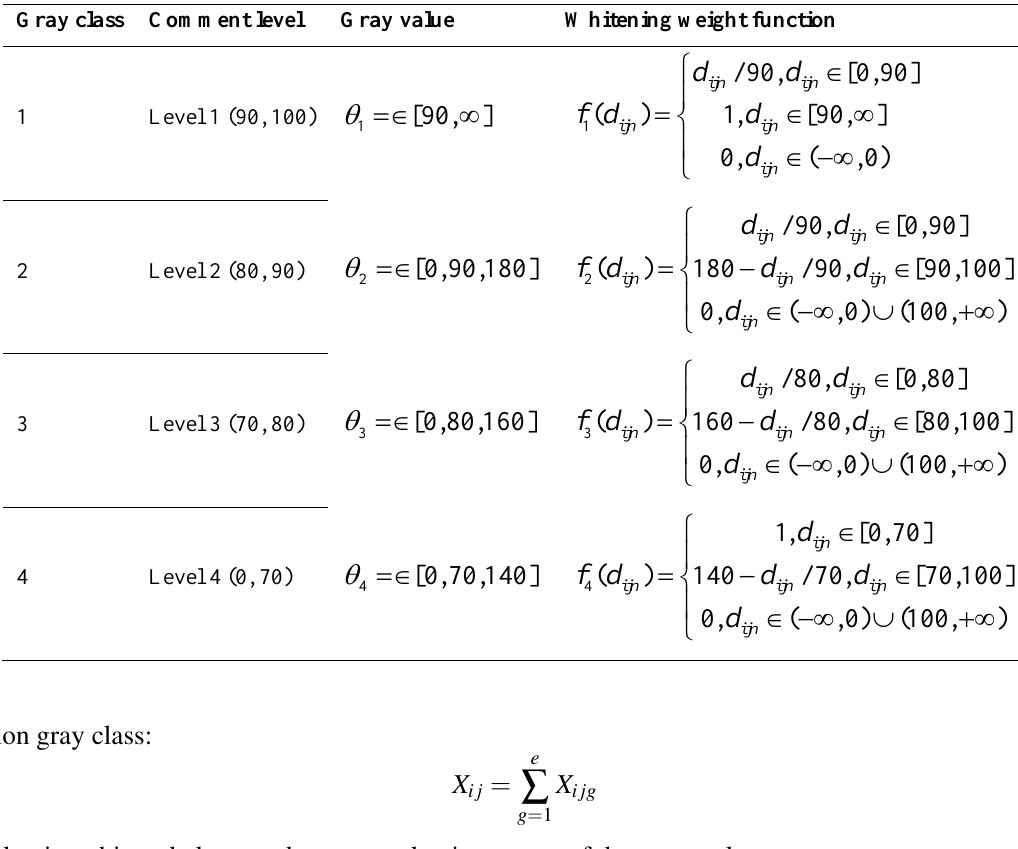
Fig. 1 System comprehensive evaluation. Table 3 Summary of whitening weight